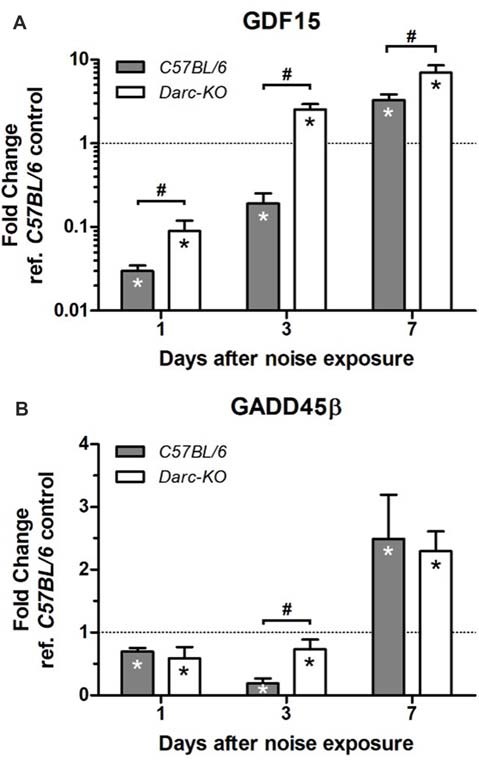
Darc deficiency improved the response of Gdf15
(A) and Gadd45β
(B) to noise exposure during the first 7 days post-noise exposure. Mice were exposed to intense OBN (112 dB SPL, 8–16 kHz, 2 h). Then, cochleae were harvested at three time point’s post-noise exposure, and the mRNA expression of Gdf15 and Gadd45β was evaluated by Real Time PCR in WT and Darc-KO mice in comparison with WT control not exposed to noise. Data are presented as fold change vs. WT control not exposed to noise, in the format of mean ± SEM. n = 4–5, *P > 0.05 vs. WT control not exposed to noise, #P > 0.05 between the two lines of mice exposed to noise.